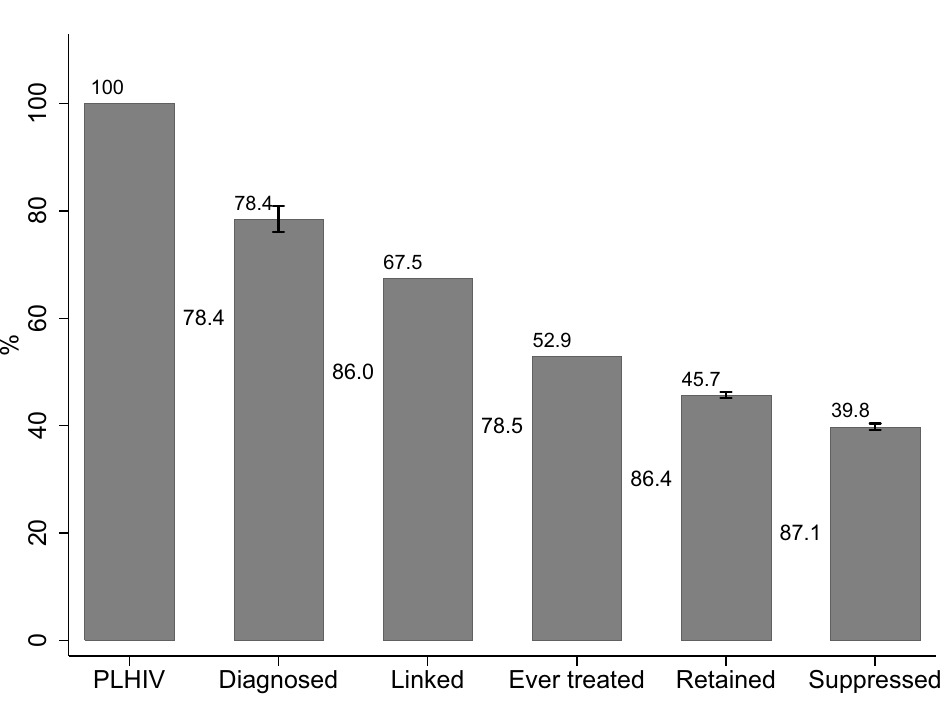
Fig 1. Cascade of care for the total population of PLHIV. The numbers between the bars correspond to proportion of the previous stage, while the numbers above the bars correspond to proportions of PLHIV. Vertical lines on the top of the Diagnosed, Retained to care and Virally suppressed bars correspond to 95% Confidence